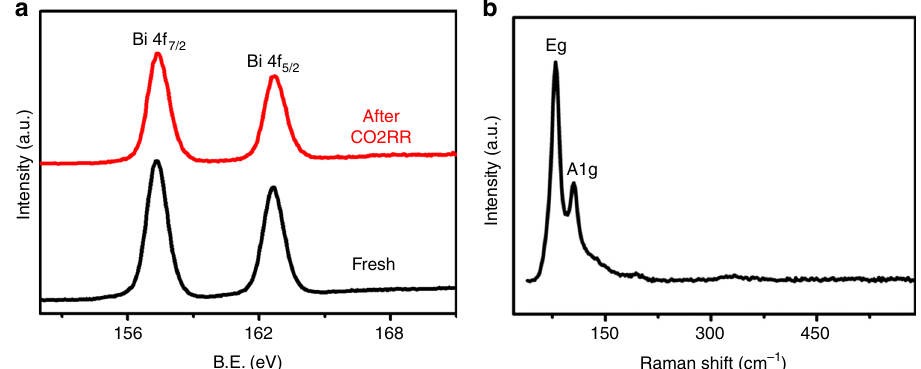
Fig. 2 Physical characterization of Bismuthene. a High-resolution Bi 4f XPS spectra before and after 75-h CO2RR process at − 0.58 V. b Raman spectrum of fresh metallic Bismuthene nanosheets.